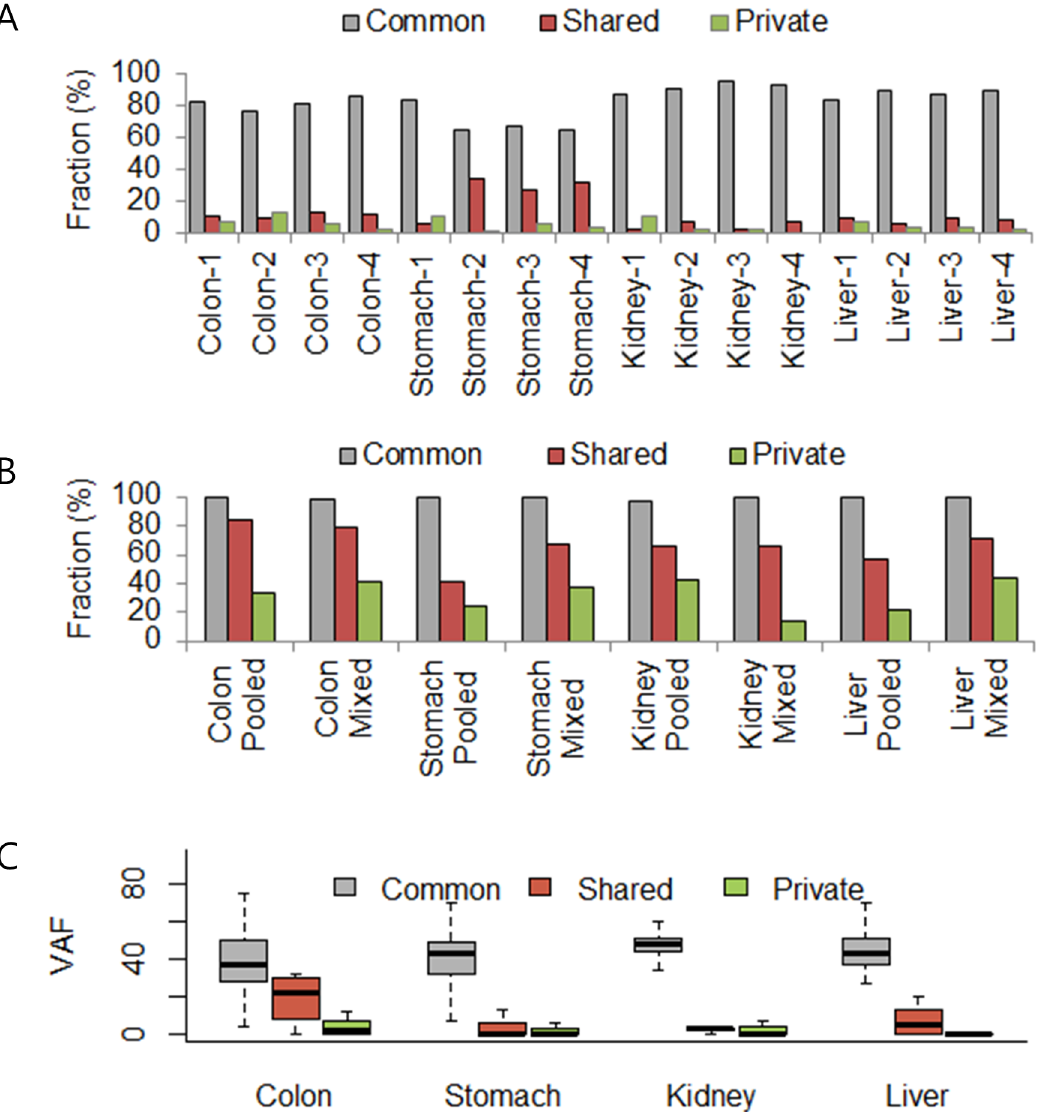
Fig 2. The characteristics of common, shared and private variants from regional samples. (A) Fractions of common, shared, and private variants identified among different regions. (B) Fractions of common, shared, and private variants identified from pooled- or mixed-samples. (C) Variant allele frequency (VAF) distribution of common, shared, and private variants identified among different